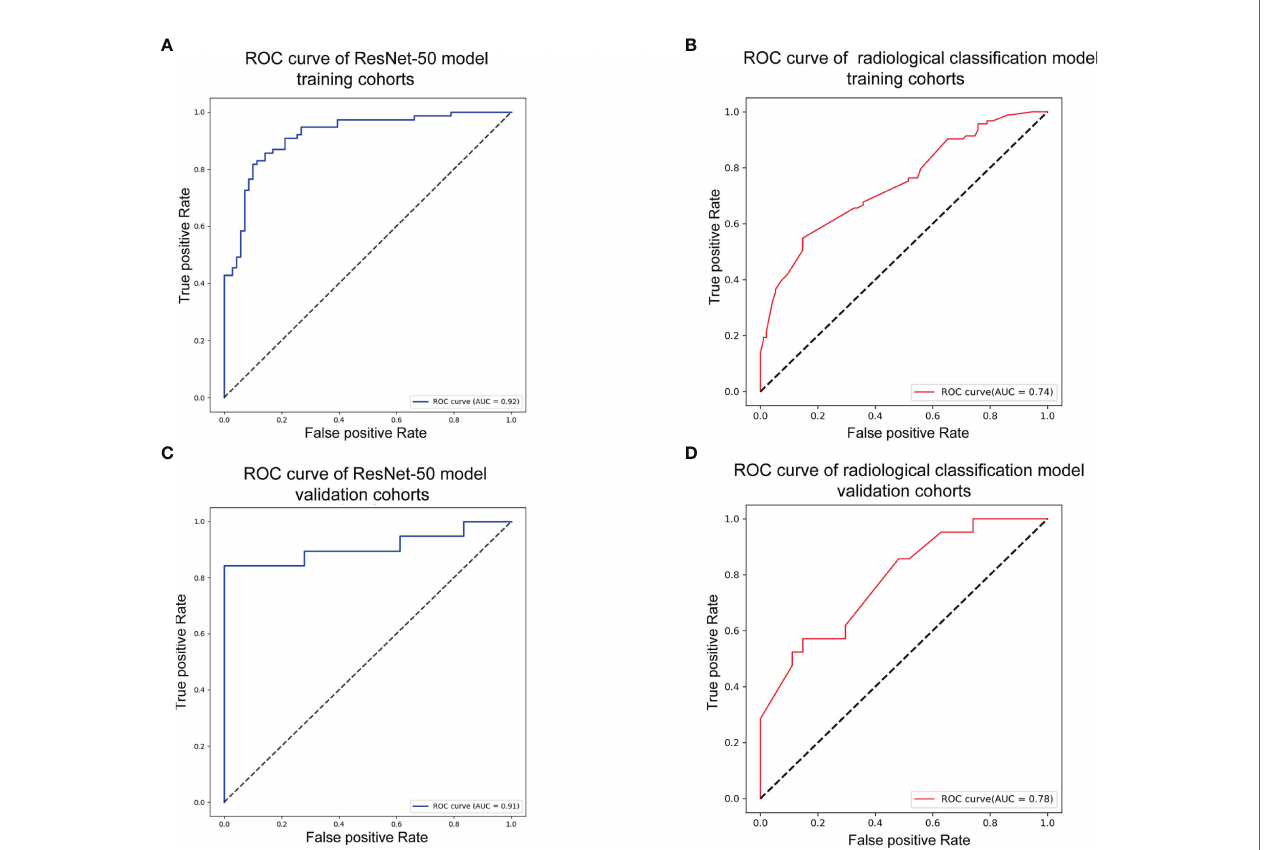
FIGURE 4 | Model evaluation. (A) Receiver-operating characteristic (ROC) curve of the transfer model in the training set with receiver-operating characteristic curve area under the curve (AUC) of 0.92. (B) ROC curve of the radiological feature classi fi cation model in the training set with AUC of 0.74. (C) ROC curve of the transfer model in the validation set with AUC of 0.91. (D) ROC curve of the radiological feature classi fi cation model in the validation set with AUC of